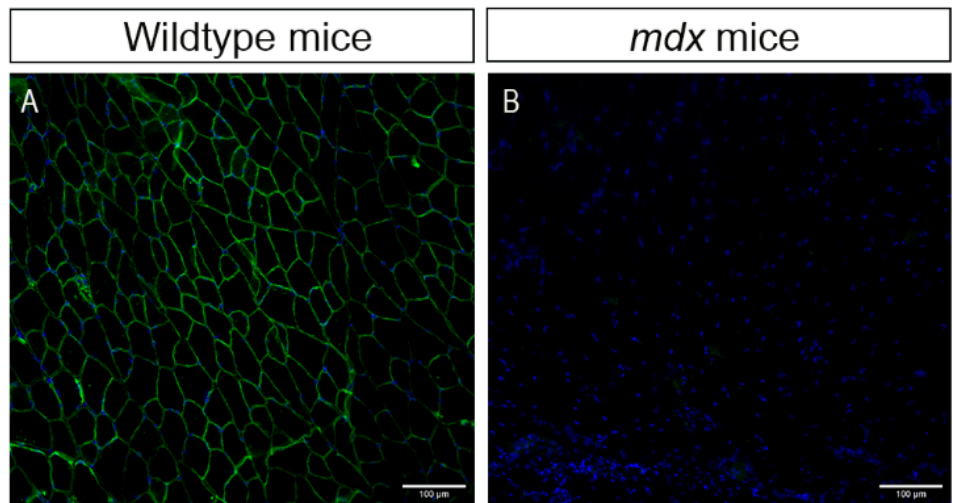
Figure 1. Dystrophin protein immunostaining in the psoas muscle of mice. ( A ) Wildtype mice (control); dystrophin present in green. ( B ) mdx mice (dystrophic); dystrophin absent. Cell nuclei were stained with DAPI (blue). Images were obtained with the ImageXpress XLS System microscope at 20× magnification. Scale bar = 100 µm.